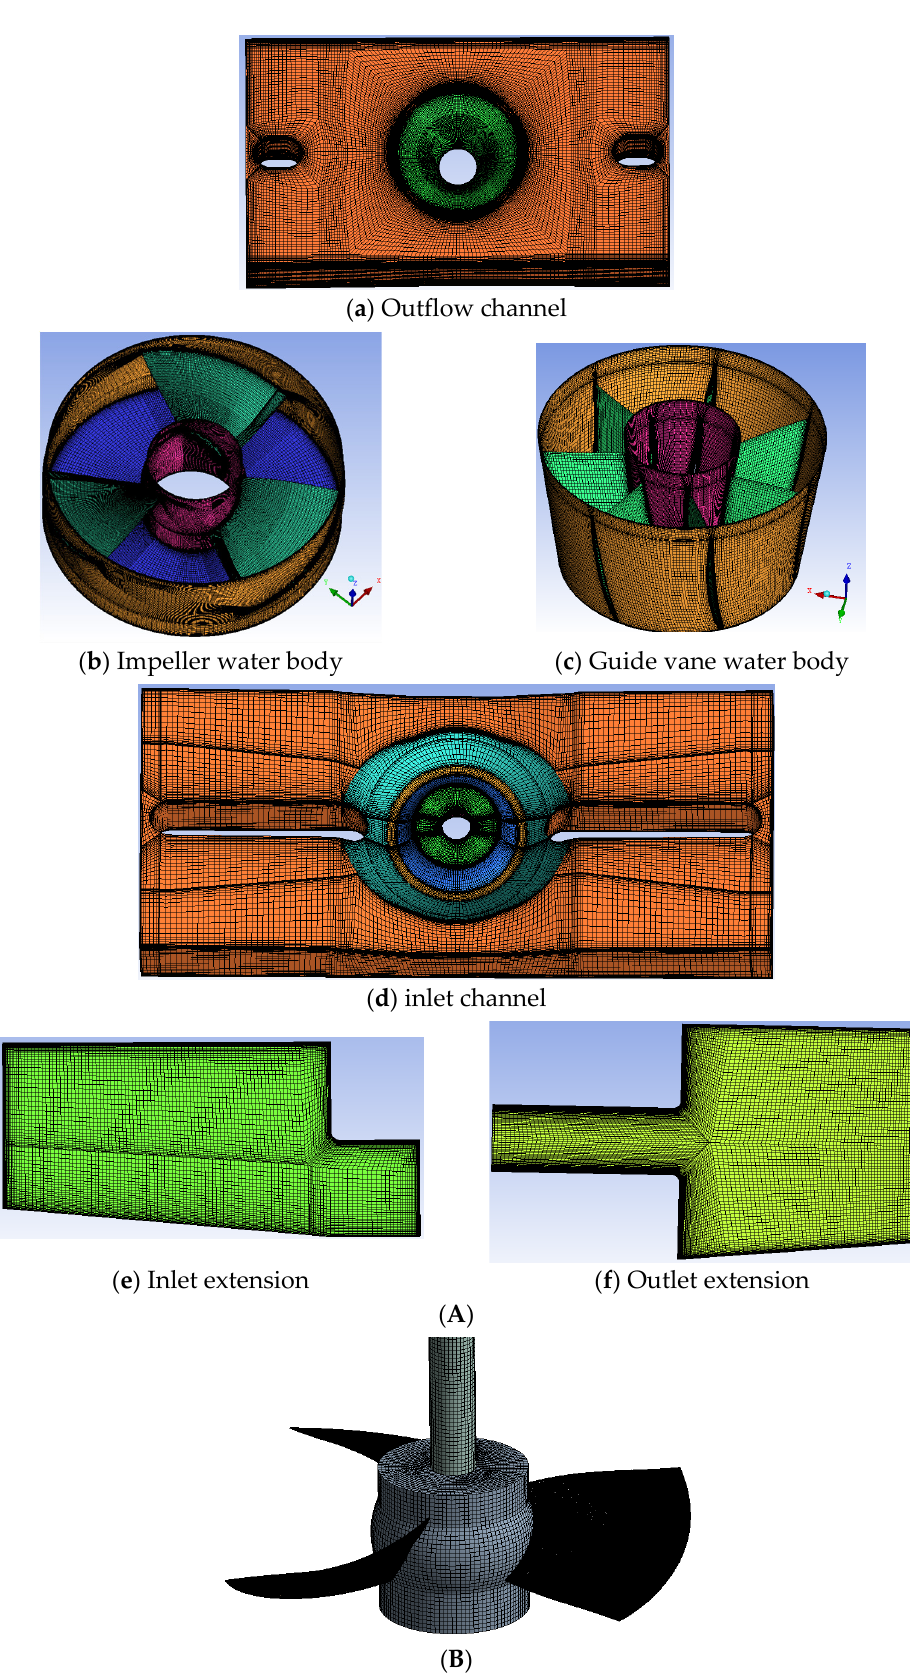
Figure 6. ( A ) Full flow channel structured grid, ( B ) Impeller grid.